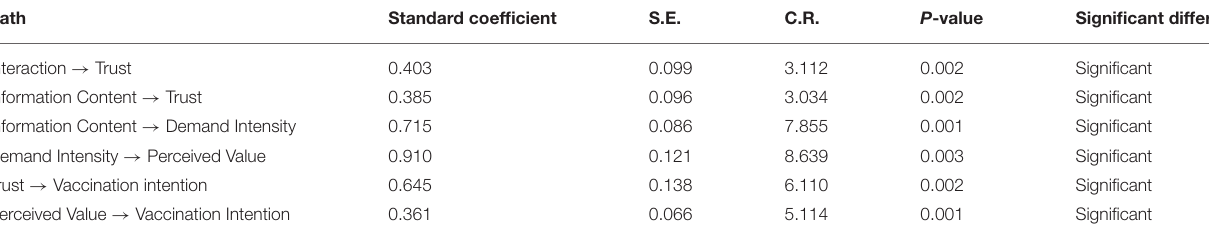
TABLE 6 | Corrected standard path coefficient and significance